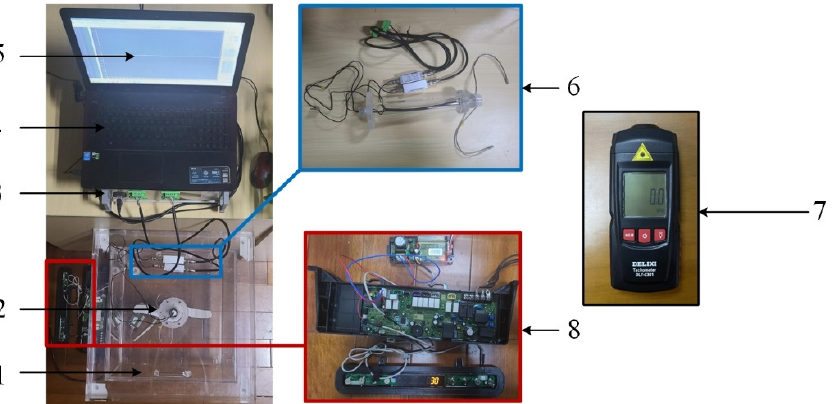
Figure 16. New type of dishwasher pump, real test bench. 1: water tank, 2: dishwasher pump. 3: data-acquisition system, 4: computer. 5: software interface, 6: rotating pressure pulsation test device, 7: tachometer, and 8: motor speed controller.